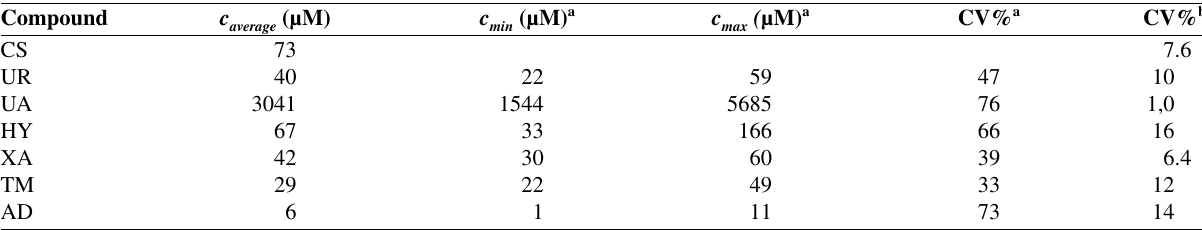
Table 3. Results of concentrations of nucleobases in urine